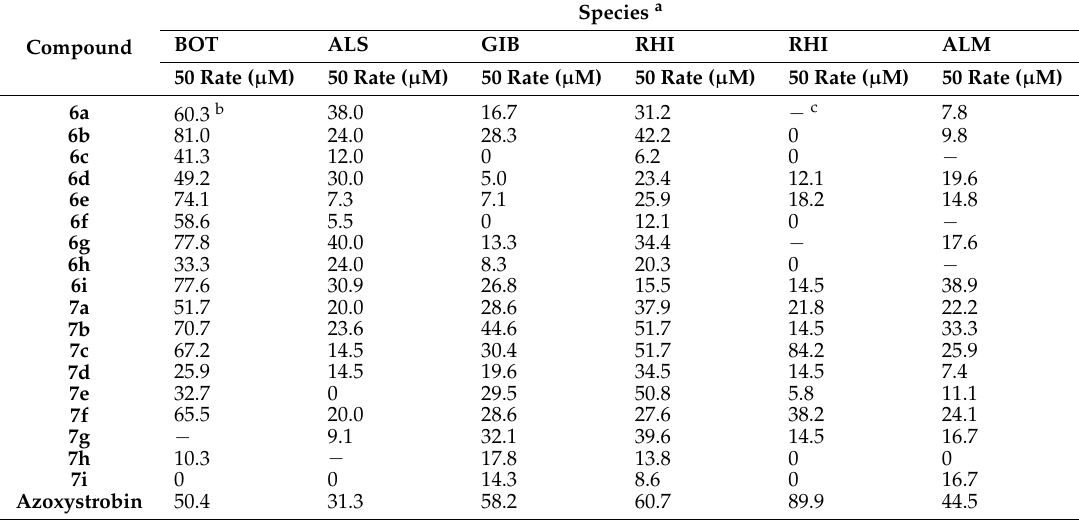
Table 1. Antifungal activity of coumarin ring-opening derivatives (inhibitory rate, %).